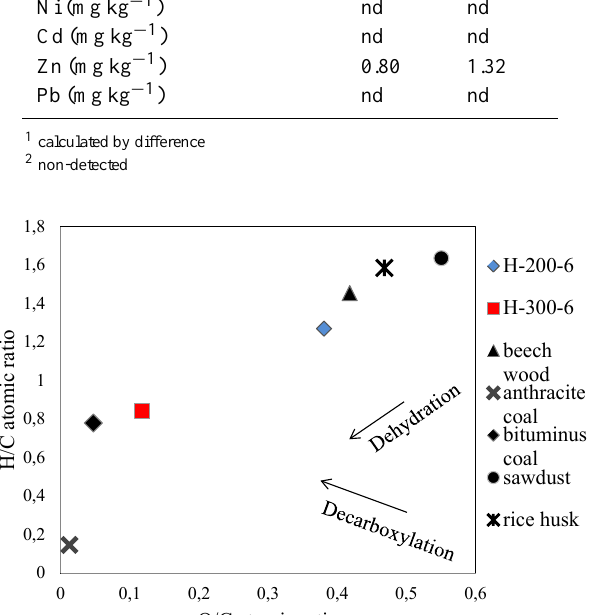
Figure 2 . Van Krevelen diagram showing the position of H-200-6 and H-300-6 Figure 2. Van Krevelen diagram showing the position of H-200-6 and H-300-6 hydrochars among known fuels and biomass materials.